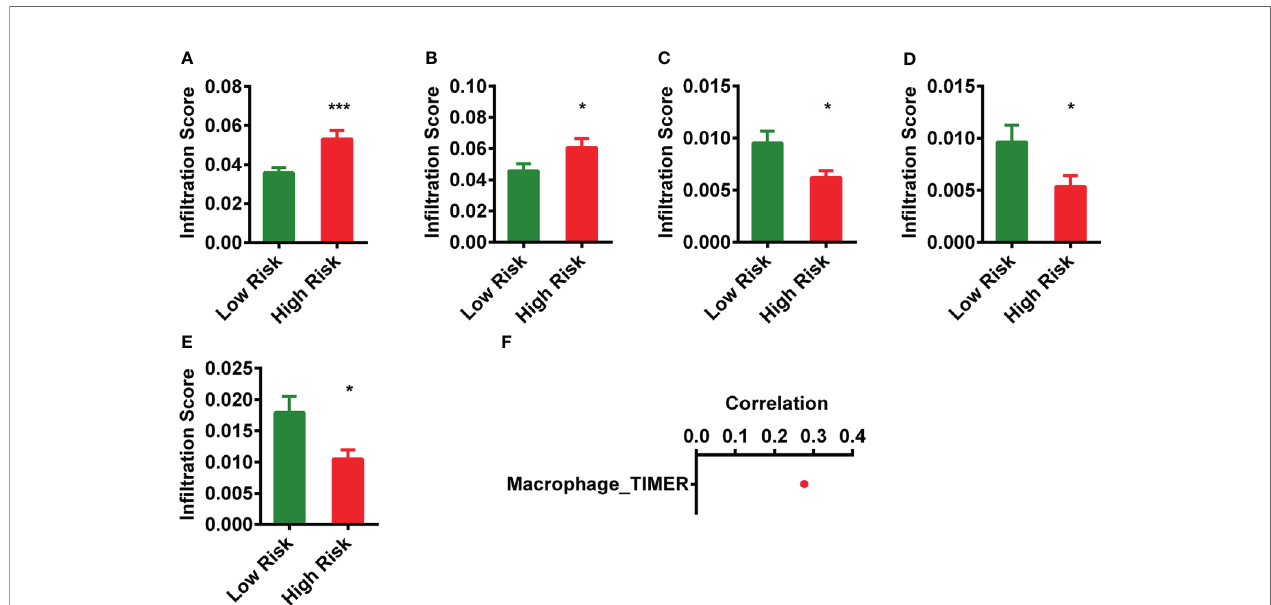
FIGURE 4 | Estimation of tumor-in fi ltrating immune cells with risk assessment model. (A – E) The in fi ltrating score of fi ve immune cells and immune factors (A) , Macrophage_TIMER; (B) , Macrophage M0_CIBERSORT-ABS. (C) , B-cell plasma_XCELL. (D) , Class-switched memory B cell_XCELL. (E) , Plasmacytoid dendritic cell_XCELL) between low- and high-risk groups were difference signi fi cantly. (F) Patients in the high-risk group were more positively associated with Macrophage_TIMER. *p < 0.05; ***p <